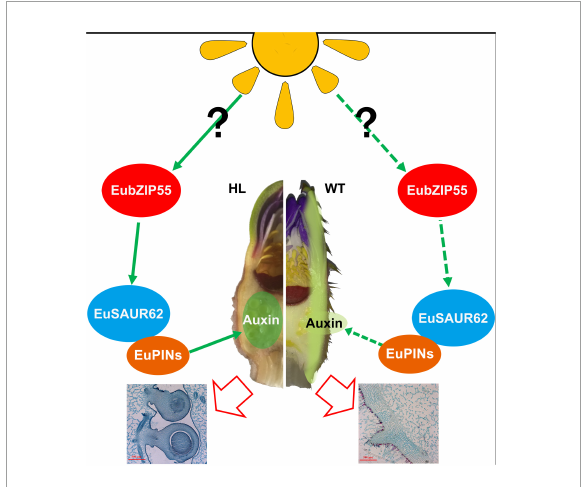
FIGURE9 A working model of the role of EuSAUR62 in regulating Euryale seed size. In HL, light increases the expression of EubZIP55, contributing to the higher expression level of EuSAUR62 , which regulates the localization of auxin by interacting with PINs, thereby promoting ovary enlargement and increasing seed size. In the WT, free-localization of auxin on the exocarp weakens the regulation of seed development and probably promotes the development of